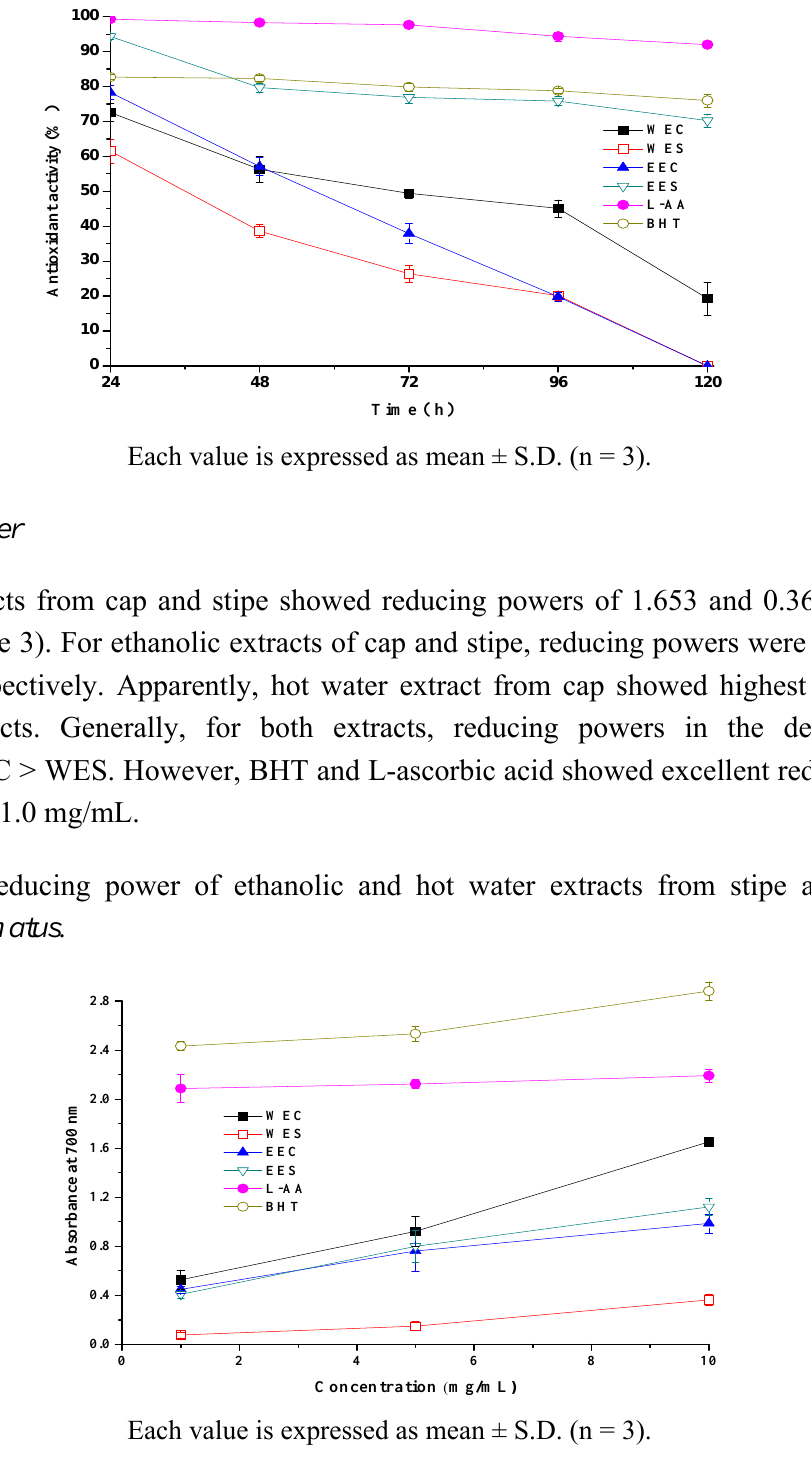
Figure 2. Change of antioxidant activity of various extracts from Coprinus comatus with time prolongation.